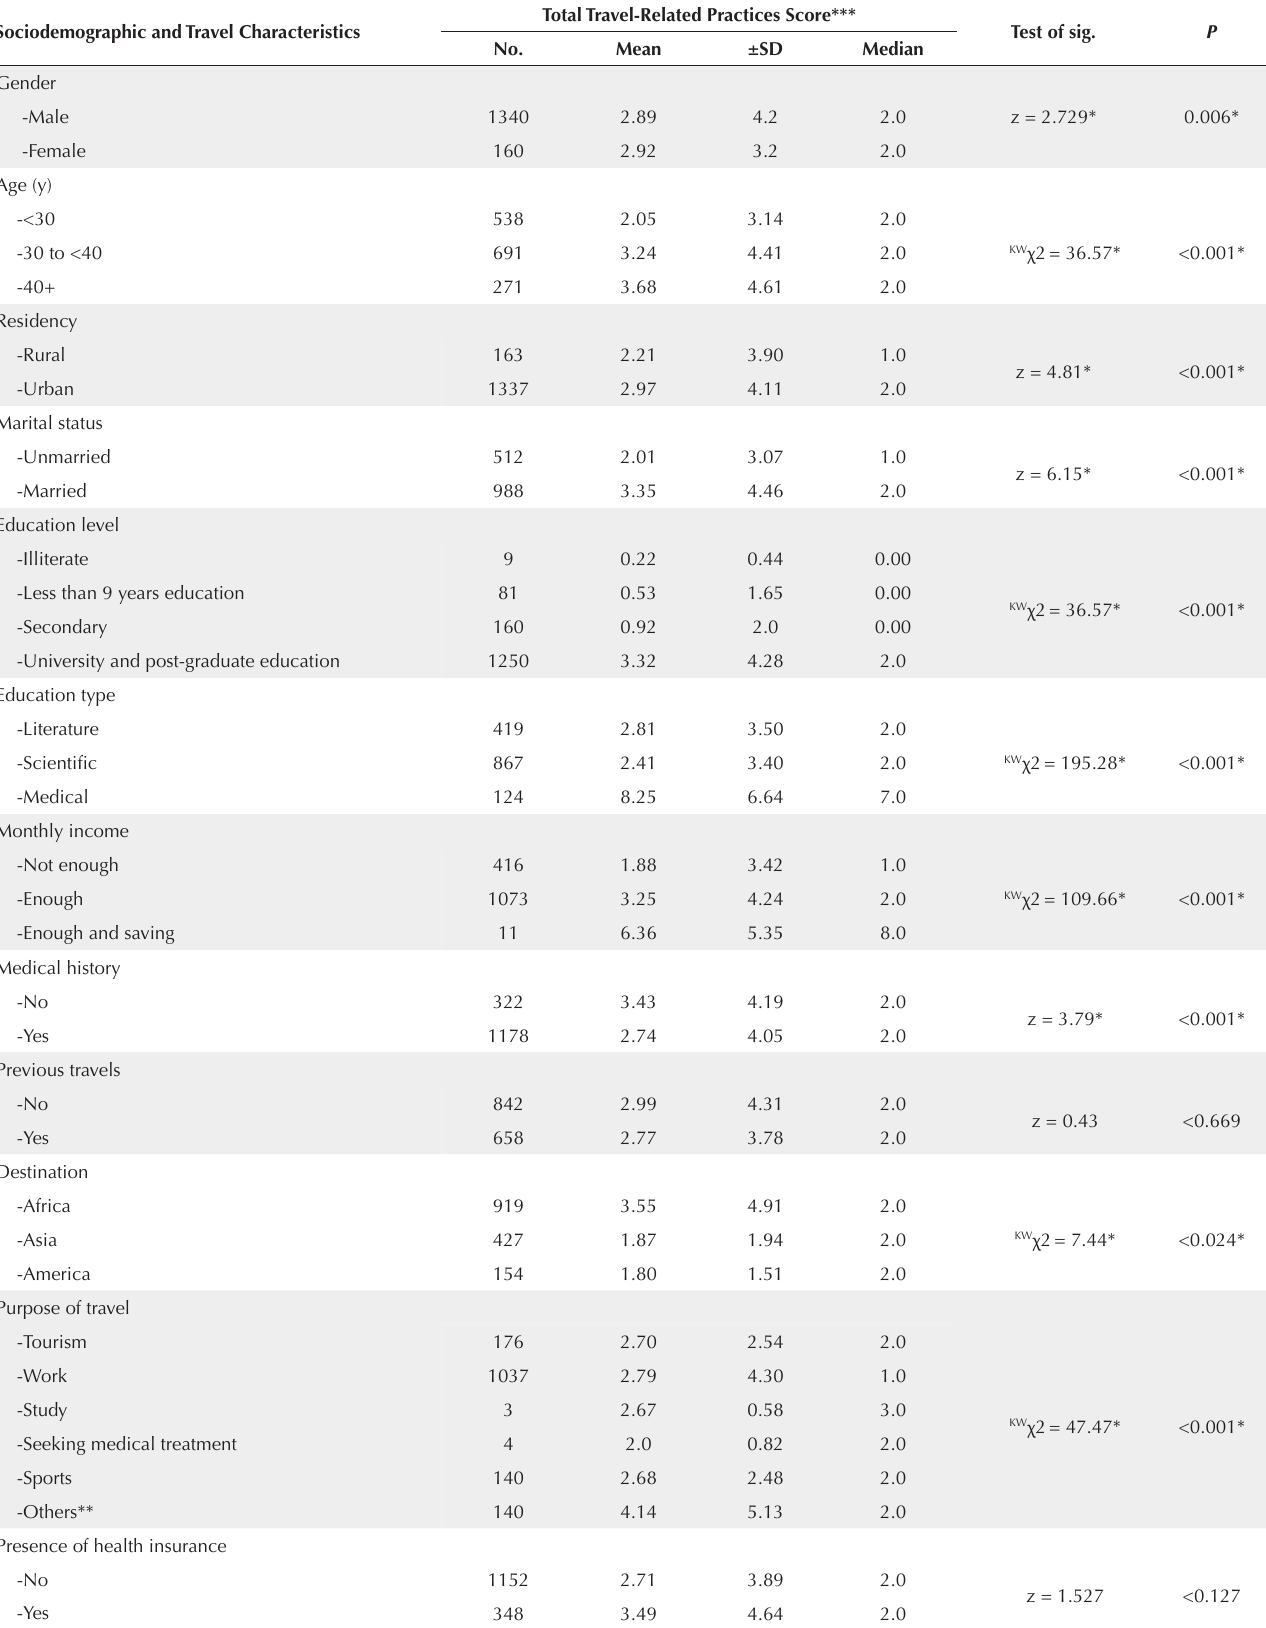
Total Travel-Related Practices Score***